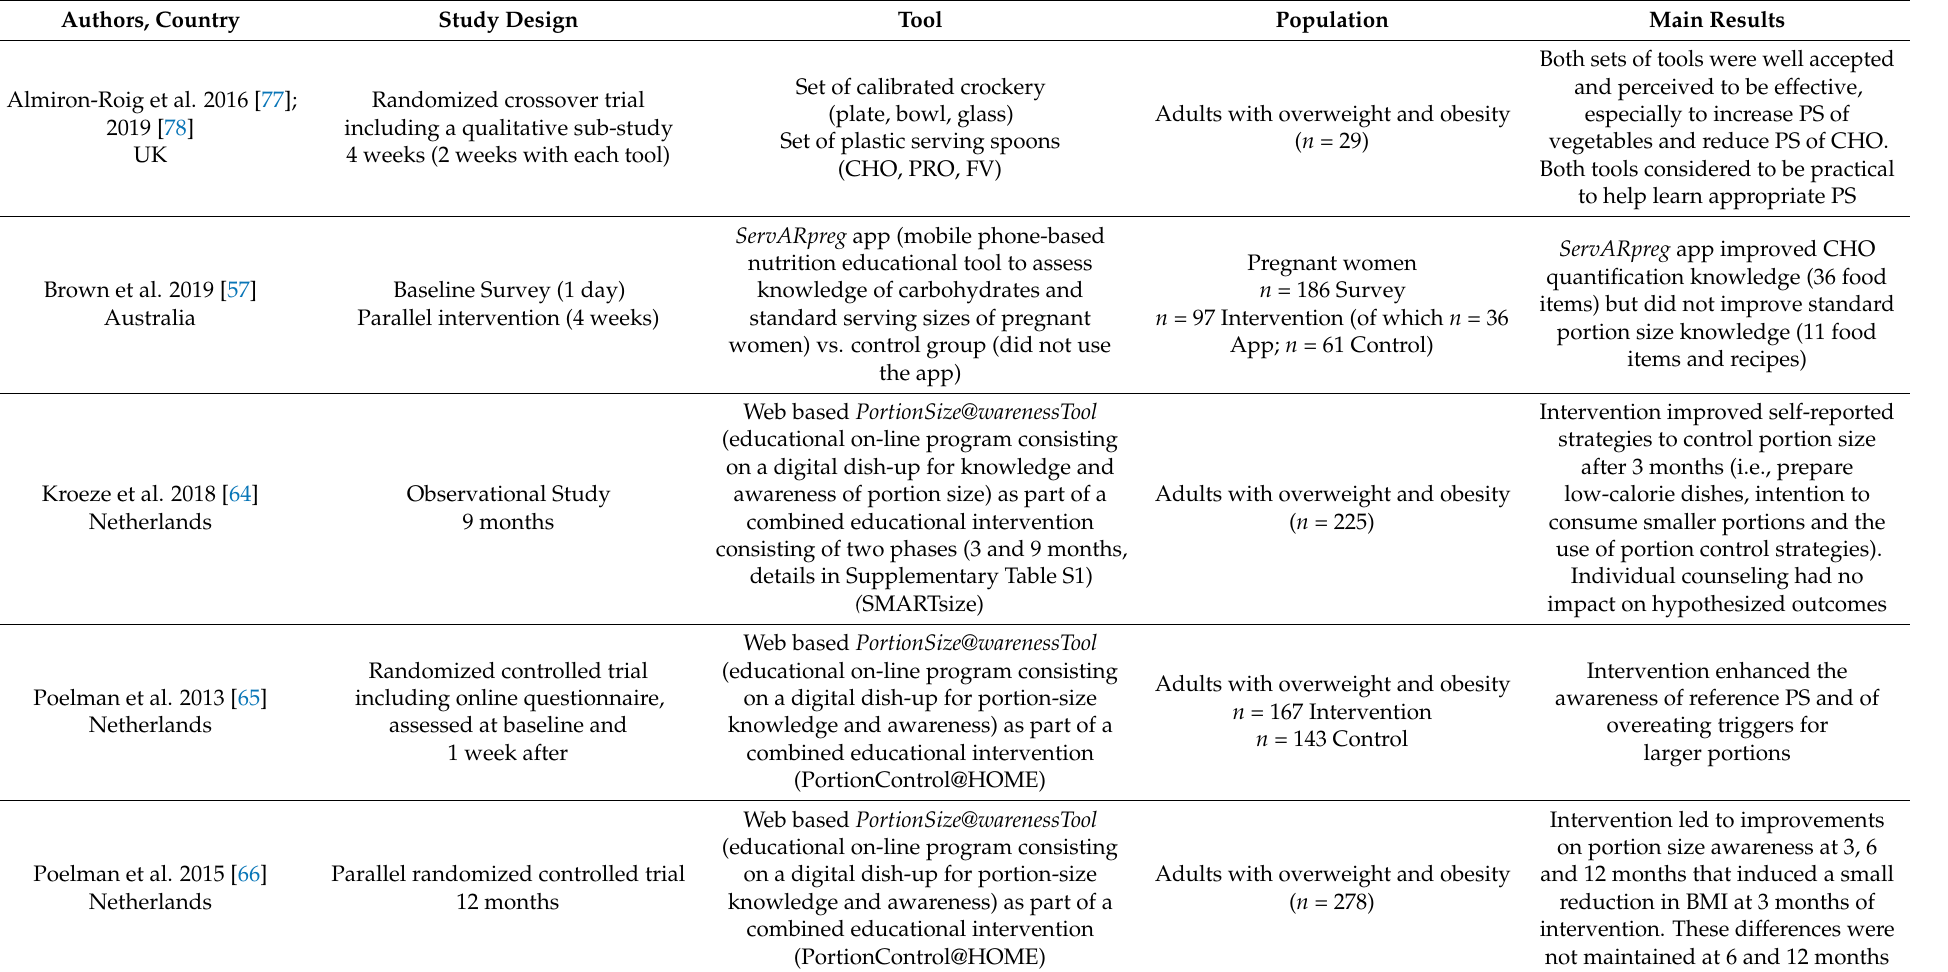
Table 3. Studies reporting changes in portion size awareness and